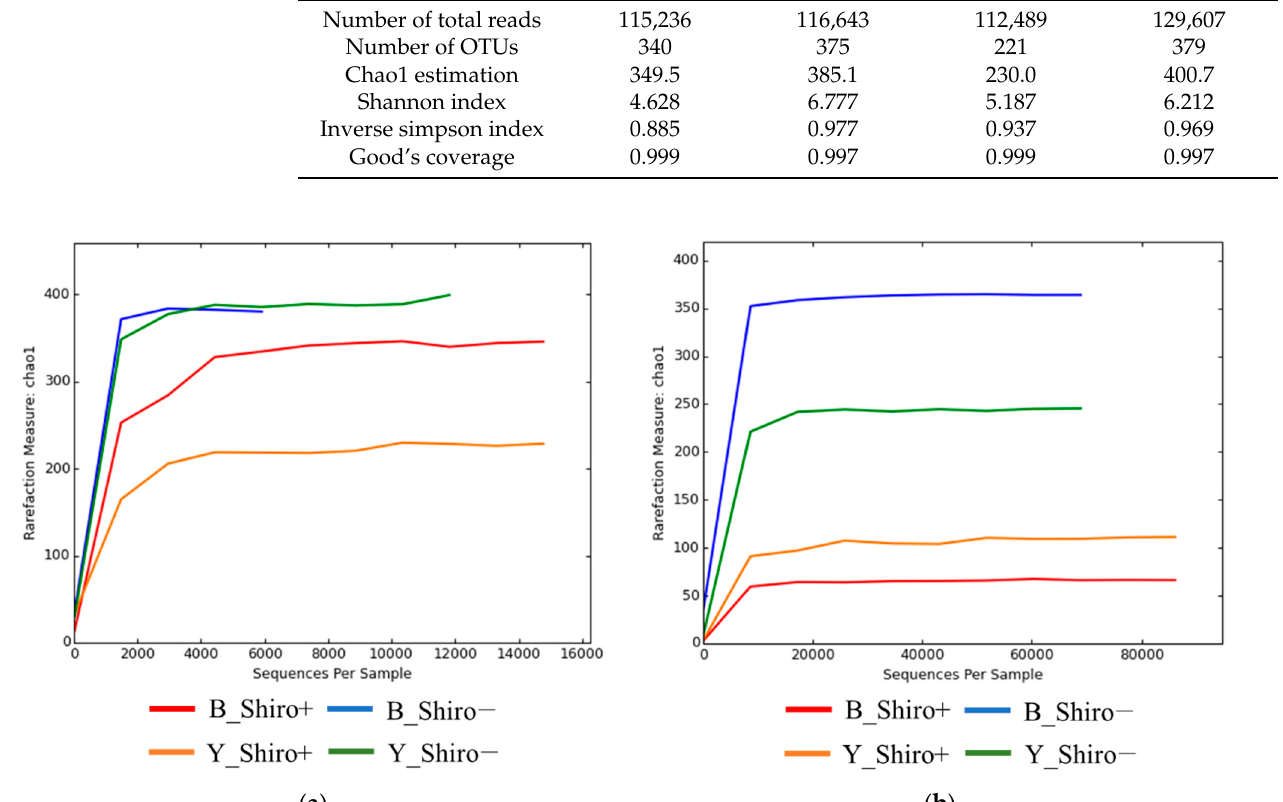
Figure 2. Rarefaction curves for chao1 of bacteria ( a ) and fungi ( b ) from soil samples inhabiting the Tricholoma matsutake production (shiro+) and nonproduction (shiro − ) soils of Bonghwa and Yangyang sampling sites.